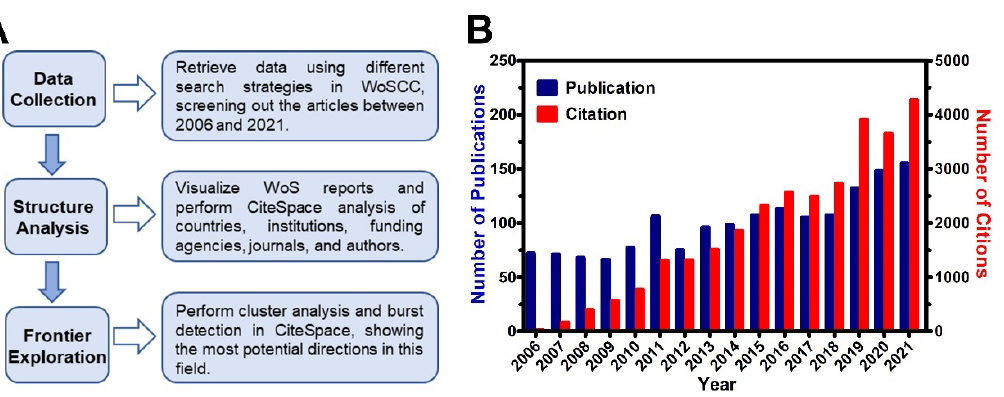
Figure 1. The flow chart of bibliometric analysis and basic profile of 5-ALA research. ( A ) The flowchart of bibliometric analysis mentioned in methods section. ( B ) The annual distributions of 5-ALA publications and their citations.